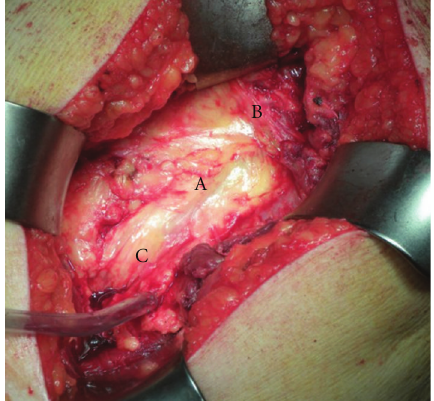
Figure 2: The sciatic nerve (A) compressed by fibrotic tissue (B) after the section of the external rotator muscles (C).